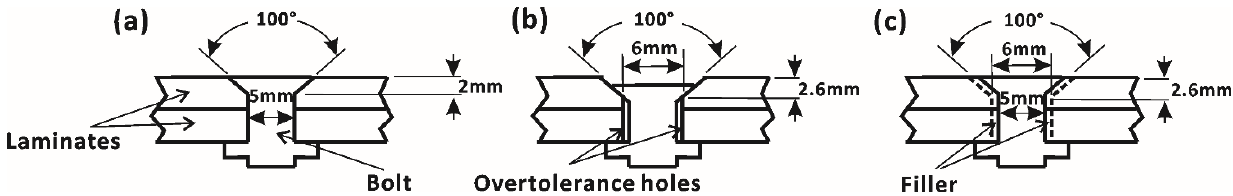
Figure 4. Geometric details of ( a ) intact, ( b ) defective and ( c ) repaired samples.